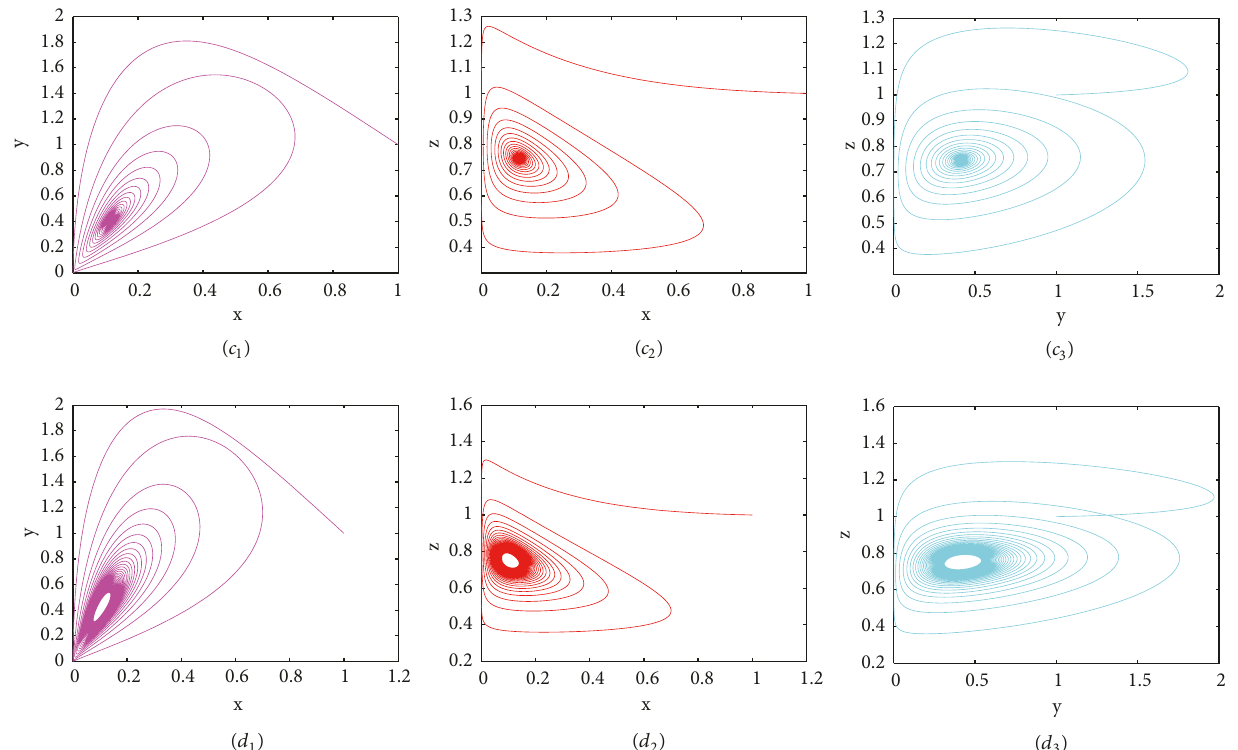
Figure 9: The results of Experiment 5: (𝑐 𝑖 ) with 𝑐 = 1.4 and (𝑑 𝑖 ) with 𝑐 = 1.575 (𝑖 = 1,2, 3) , (𝑐 1 ) and (𝑑 1 ) projected on the (𝑥,𝑦) -plane; (𝑐 2 ) and (𝑑 2 ) projected on the (𝑥,𝑧) -plane; (𝑐 3 ) and (𝑑 3 ) projected on the (𝑦, 𝑧) -plane.